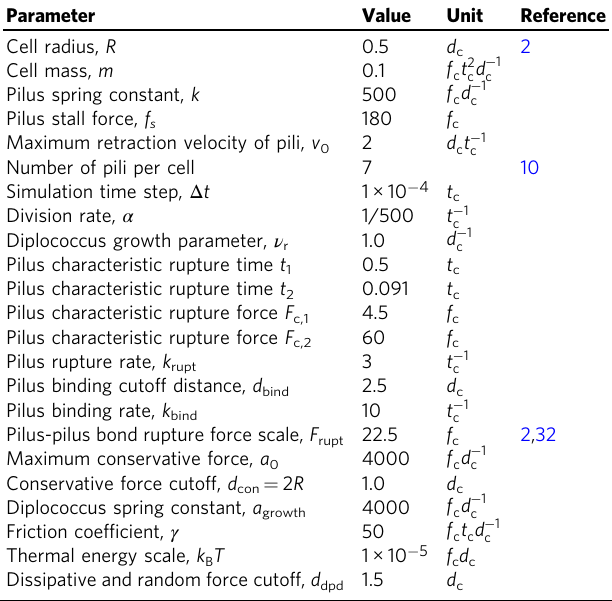
Table 1 The choice of parameters for the